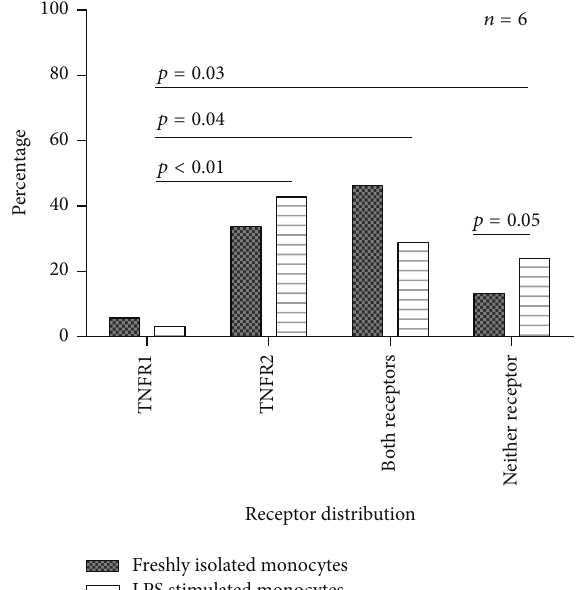
Figure3:PatternofTNF- 𝛼 receptorexpressiononmonocytes.Each column shows the mean percentage of monocytes (with SD bars) expressing each of the four possible cell surface receptor combina- tions, in freshly isolated cells and after stimulation with 100 ng/mL of LPS for 20 hours. Overall differences in receptor distribution subtype for each of the two conditions were assessed with separate Friedman’s tests and post hoc pairwise comparisons conducted if appropriate. In freshly isolated unstimulated monocytes, no overall difference was observed. In monocytes stimulated for 20 hours with 100ng/mL of LPS, Friedman’s test was significant ( 𝑝 = 0.02 ). Significant post hoc 𝑝 values are shown in the figure and were significant for comparisons with monocytes expressing TNFR1 only. Comparisons for each of the four receptor distribution subtypes between freshly isolated and LPS-stimulated monocytes were con- ducted with Wilcoxon Signed-Ranks Testing and demonstrated an increase in the percentage of monocytes expressing neither receptor in LPS-stimulated cells. The experiments represent data from 6 sub- jects. Experimental conditions for freshly isolated monocytes were conducted singly and for LPS-stimulated monocytes in duplicate (due to limitations to cell numbers